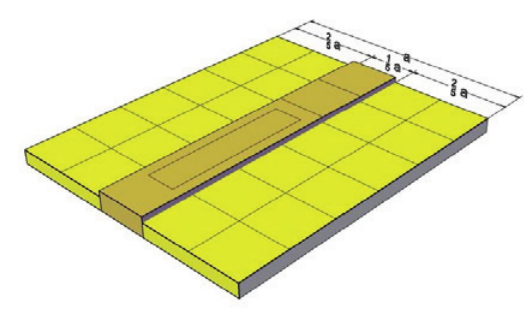
Figure 1. General division of garden (source: authors)